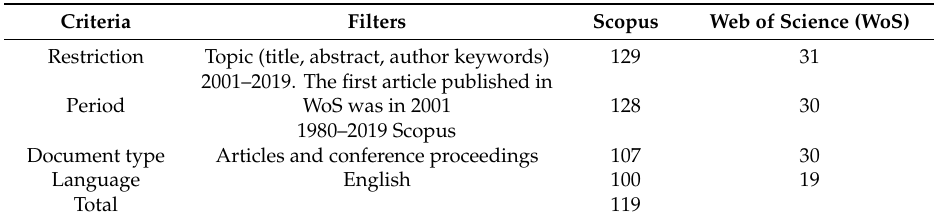
Table 3. Records obtained.